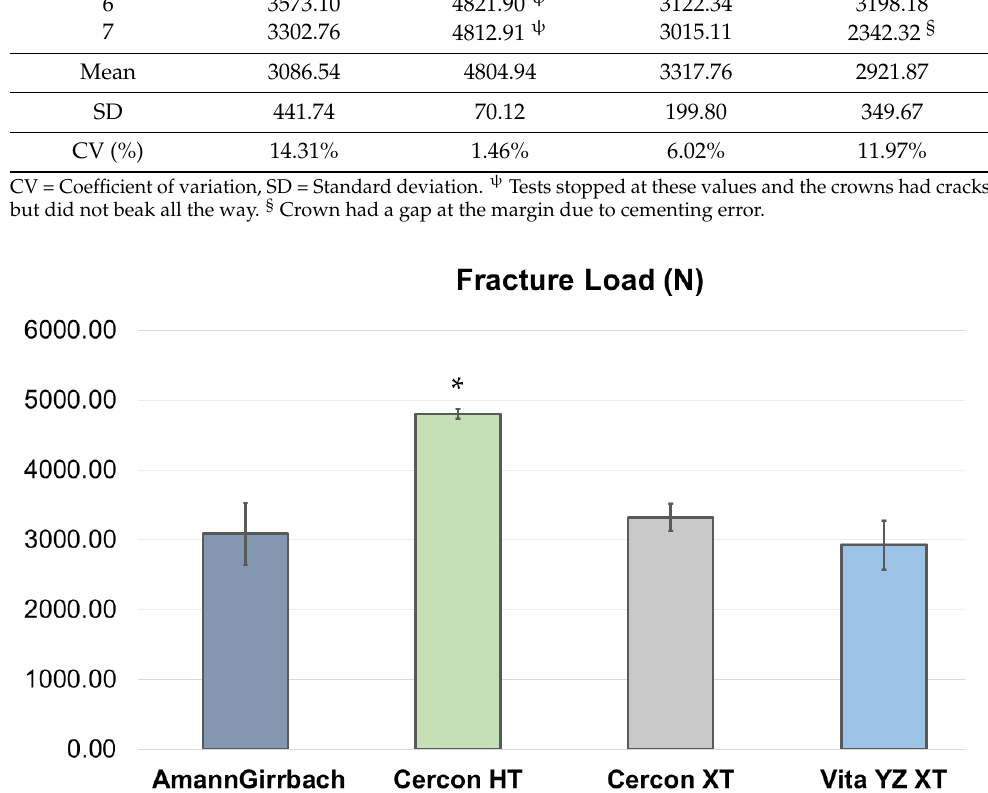
Figure 2. The mean fracture load of various zirconia; AmannGirrbach (Amann Girrbach GmbH, Pforzheim, Germany), Cercon HT (Dentsply Sirona, Bensheim, Germany), Cercon XT (Dentsply Sirona, Bensheim, Germany), and Vita YZ XT (Zahnfabrik, Bäd Sackingen, Germany). *Cercon HT presented a significantly higher fracture load compared to AmannGirrbach, Cercon XT, and Vita ZY XT ( p value <